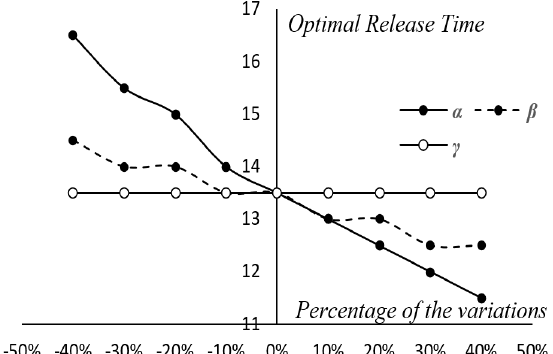
(cid:3052)(cid:3043) and 𝐺𝐶 (cid:3043) , 𝐸𝐶 (cid:3043) on the Cost.